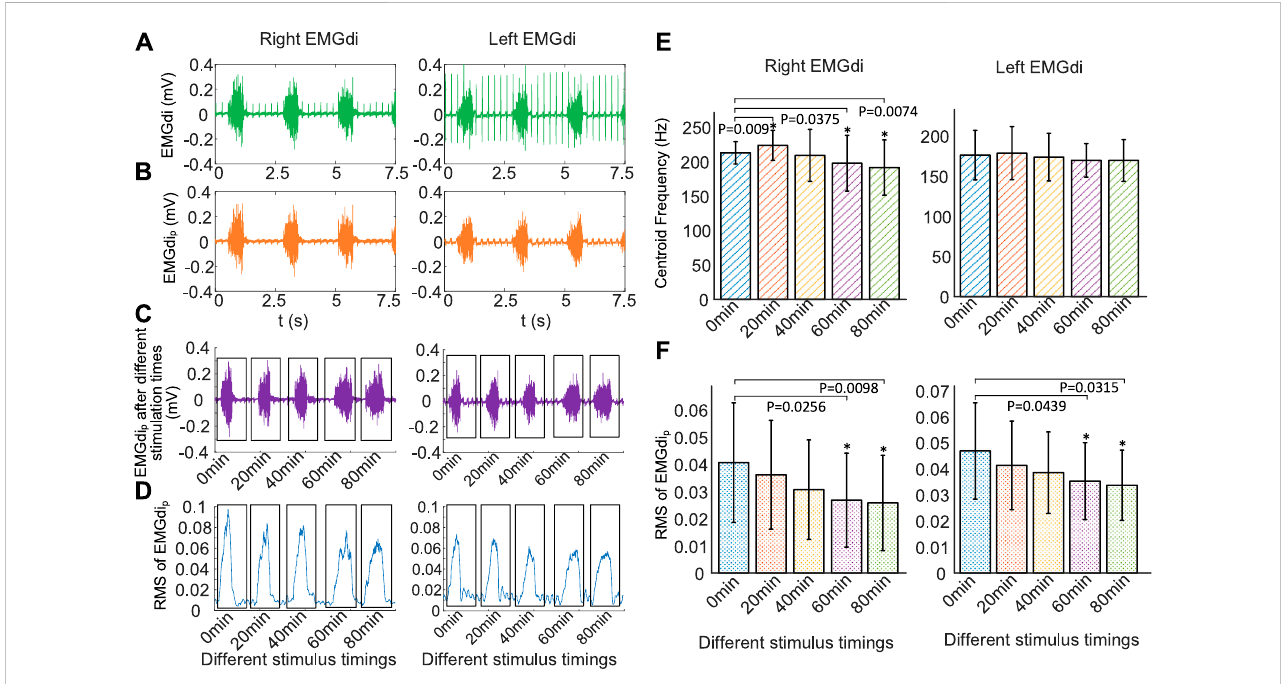
FIGURE 7 Changes of EMGdi after different stimulation time using the same stimulation parameters (0.5 mA, 250 Hz, 160 μ s, 30 times/min, 1:3). (A) EMGdi signals, (B) EMGdi p signals without ECG, (C) EMGdi p after stimulation time of 0, 20, 40, 60, and 80 min, respectively, (D) RMS for the EMGdi p shown in (C) , increasing the duration of DP results in a gradual decrease in EMGdi, (E) mean centriod frequency ( f c ) and (F) RMS of EMGdi p after different stimulation time for fi ve rabbits.* p < .05 in comparison to 0 min values. The increase of stimulus time makes the mean RMS of EMGdip (right EMGdi p and left EMGdi p )